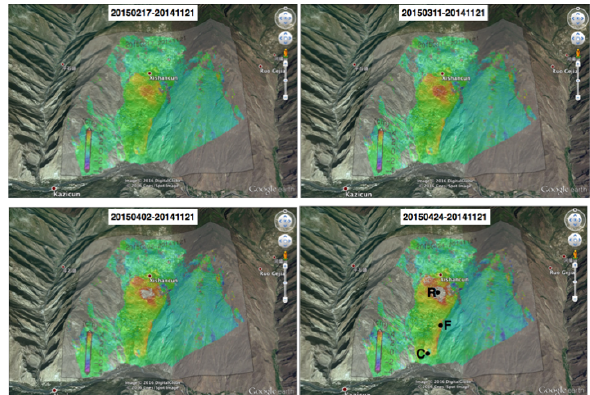
Figure 6. Time series evolutions of Xishancun Landslide acquired from TerraSAR-X datasets From the time series results from multi-platform radar observations, it can be concluded that the middle and eastern parts of the landslide body deformed for two and a half years, but the overall deformation range did not expand significantly. The front edge and rear edge of the landslide body did not have obvious deformations, and the whole landslide was still in the creeping stage.